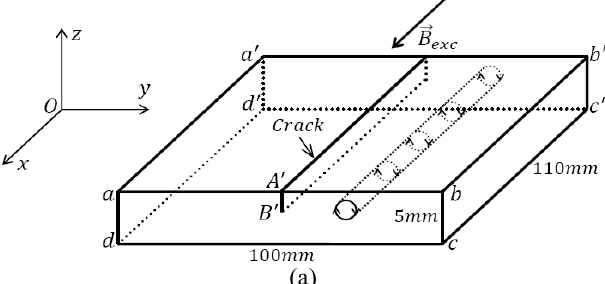
Figure 9 (a): Small solenoids parallel to the zero volume crack corresponding to the current loops shown in figure